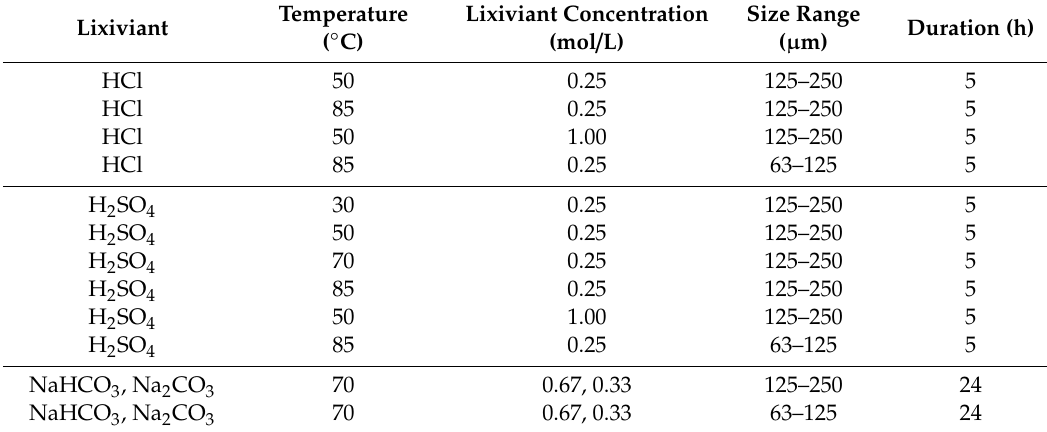
Table 1. Leaching conditions used in this